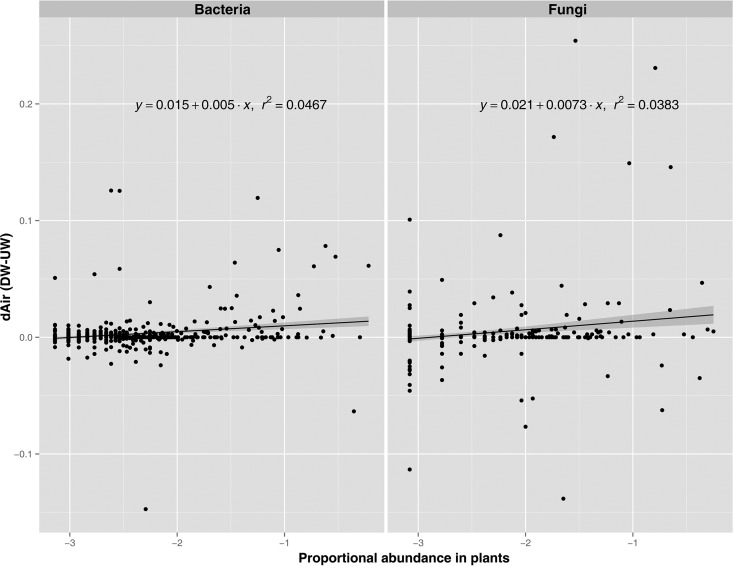
Least-squares linear regression analysis of the difference in the proportional abundances of a given OTU found in downwind air and in upwind air (dAir = DW − UW) against the log-normalized proportional abundance of this OTU on plants at the sample site. The proportional abundances on plants (x axis) were log transformed [log(x + 1)] to better illustrate this relationship given the wide range of proportional abundances of the OTUs. Only OTUs that represented ≥0.1% of the reads in a given plant sample were included (bacteria, n = 716; fungi, n = 537). Two OTUs having unexplainably high abundances in one sample were omitted (bacteria, OTU1 in L10; fungi, OTU3 in L01). Sample sites for which sequences from all three habitats were not available were not included (bacteria, L01 and L04; fungi, L06, L07, and L10).